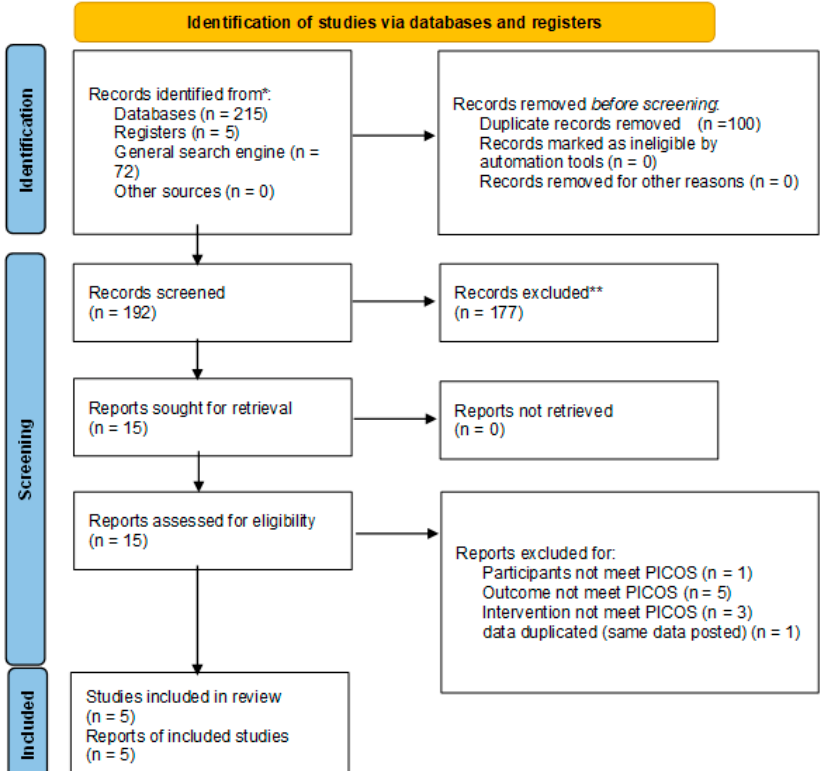
Figure 1. The results of the search